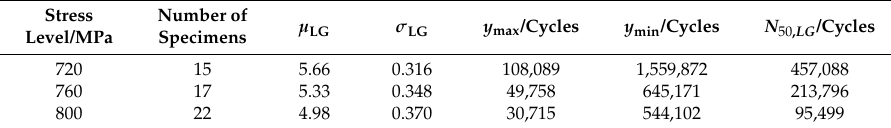
Table 1. Fatigue life distribution under a lognormal distribution (LG).